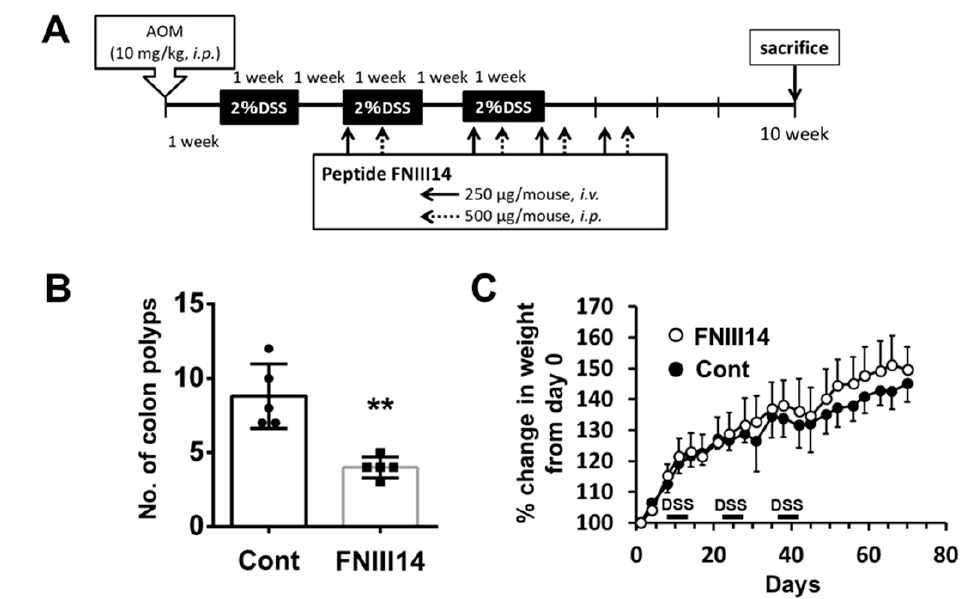
Figure 5. Peptide FNIII14 is capable of suppressing the incidence of colon polyps in the murine AOM/DSS colitis-associated carcinoma model. ( A ) Schematic of the administration of AOM, DSS, control peptide, and peptide FNIII14 to the mice. ( B ) The effect of peptide FNIII14 on the development of colitis-associated colorectal cancer in the AOM/DSS mouse model. Dot plots show the numbers of colon polyps of individual mice in each group with bars representing the means ± standard deviation, ** p < 0.01. ( C ) Body weight profile of the animals. Data represent the means ± standard deviation.